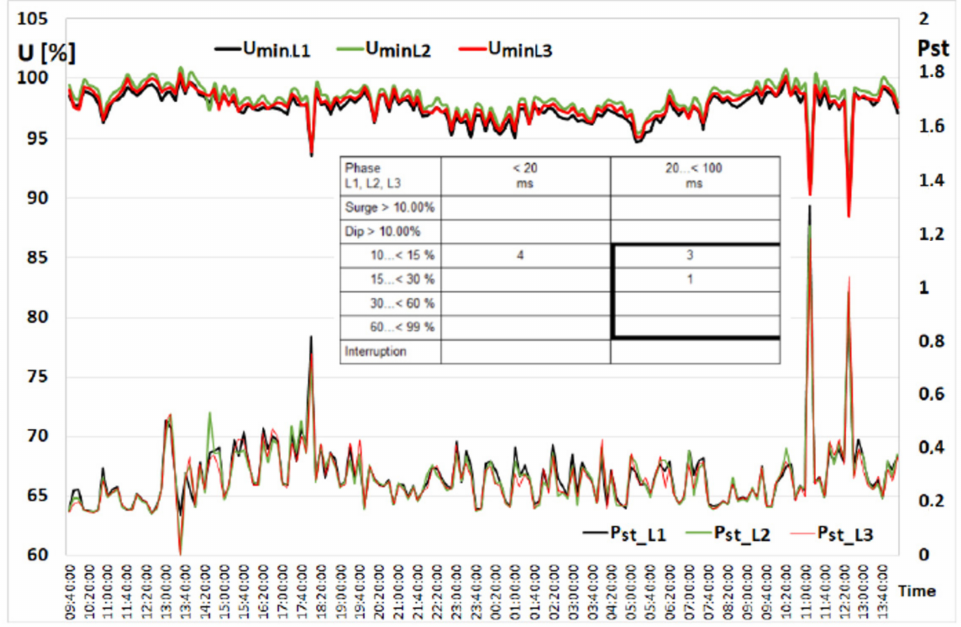
Figure 25. Voltage U min , short-term flicker indicator P st and dips recorded at points D-phases L1, L2, L3.